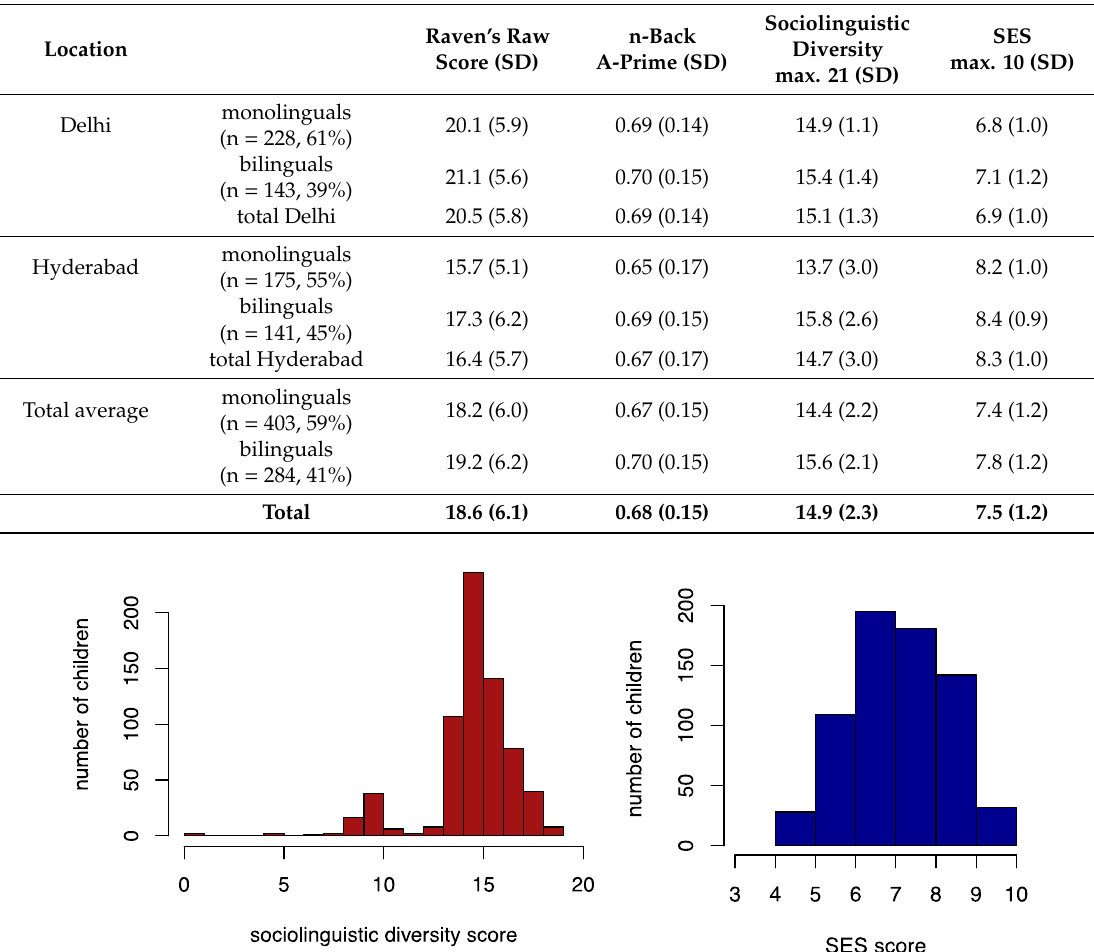
Table 2. Overview of the average scores on the cognitive tasks and the questionnaires (SES = socio ‐ economic status; SD = standard deviation).